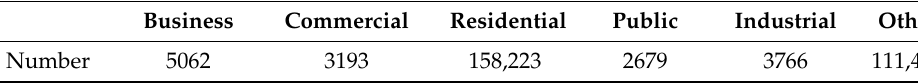
Figure 2. Distribution of building uses in Sapporo. Table 2. Number of buildings.